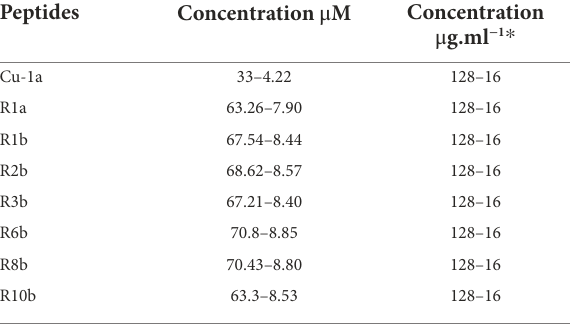
TABLE 1 Concentrations in μ M and μ g.ml − 1 used in activity assays against bacteria, fungi, RAW264.7 cells, and tumor cells.